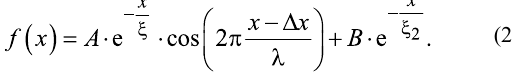
wavelength is much more robust, showing only a slight varia- tion for starting points of the fit larger than 60 nm. The oscilla- tions of the wavelength are of much lower magnitude and with a different phase shift compared to the amplitude and decay length, emphasizing the independence of λ from A and ξ . The period of those deviations, 53 nm for the amplitude, 55 nm for the decay length and 56 nm for the wavelength, are very simi- lar and close to the average of the wavelength 56 ± 4 nm, which is actually the period of the oscillatory structural forces itself. For separations of 180 to 230 nm all three parameters seem to remain constant. Figure 4 displays the fit made at a starting point of 200 nm (solid gray line) and the extrapolation towards smaller separation (dashed gray line).